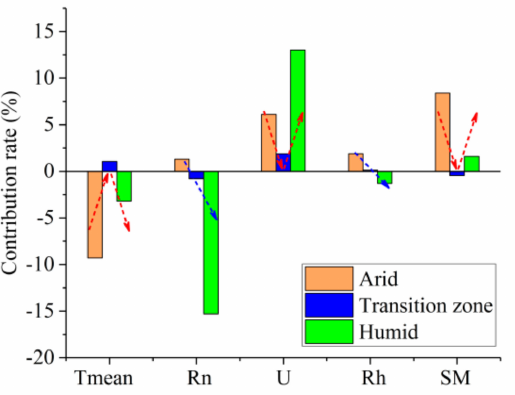
Figure 12. Contribution of environmental factors to precipitation-use efficiency (PUE). Tmean is air temperature, Rn is the net radiation, U is the wind speed at 10 m, Rh is the relative humidity, and SM is soil